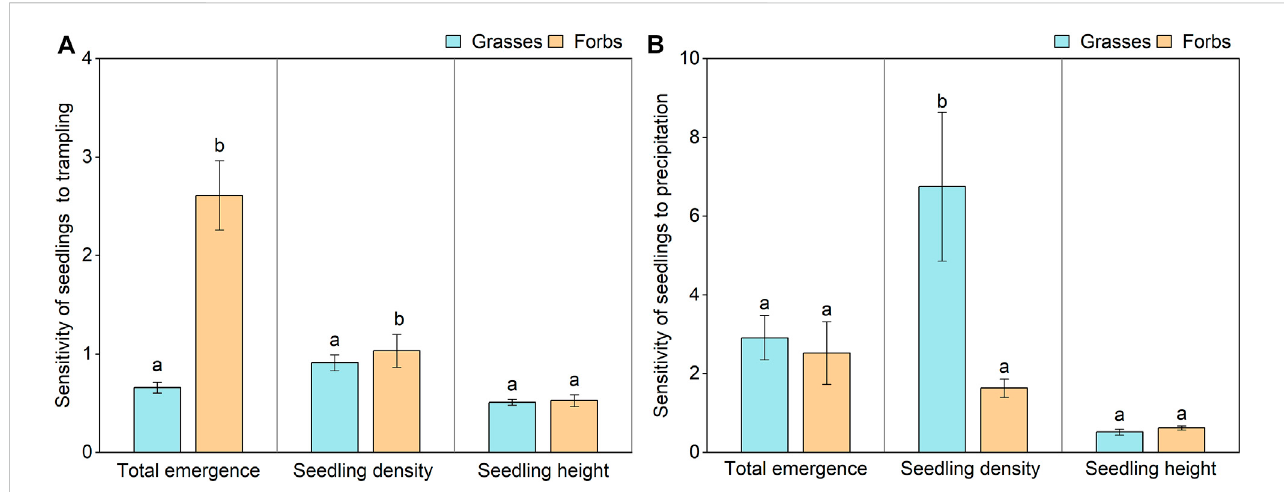
FIGURE 5 Sensitivities of total seedling emergence, seedling density and height of the grasses and forbs to trampling disturbance and precipitation variation. (A) Sensitivity of seedlings to trampling disturbance; (B) Sensitivity of seedlings to precipitation variation. Different letters indicate signi fi cant difference in sensitivity between the grasses and forbs in same groups at 0.05